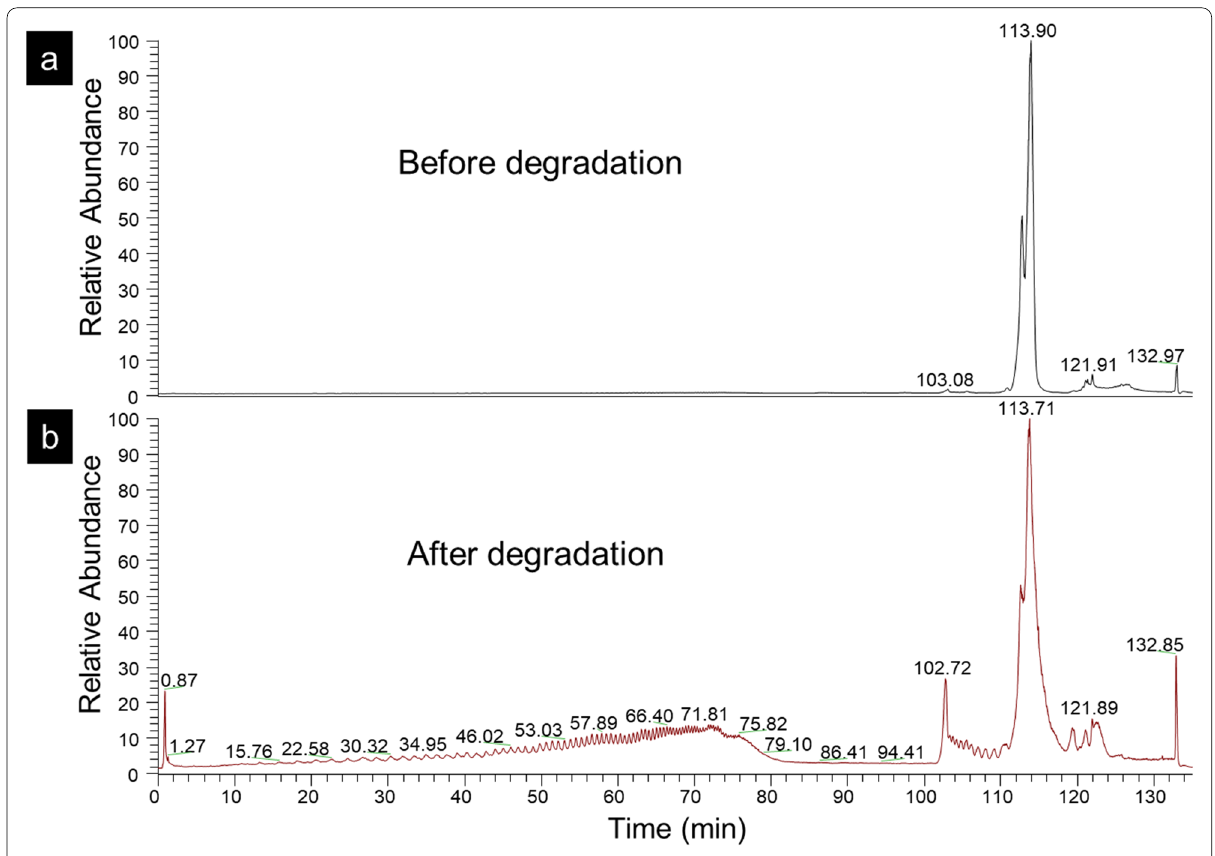
Fig. 7 The LC-HRMS of P188 before ( a ) and after ( b ) degradation